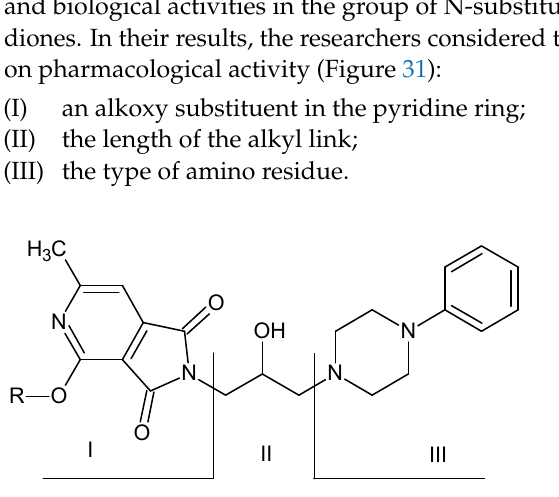
Figure 31. Structure of imides. (I) 3,4-pyridinedicarboximide (R=CH 3 , C 2 H 5 ), (II) linker, (III) type of amino residue [37].